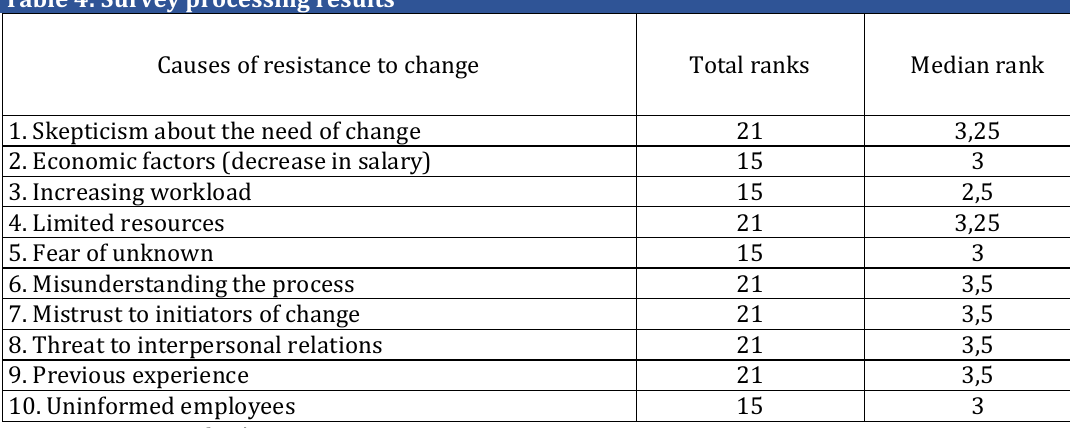
Table 4: Survey processing results Causes of resistance to change Total ranks Median